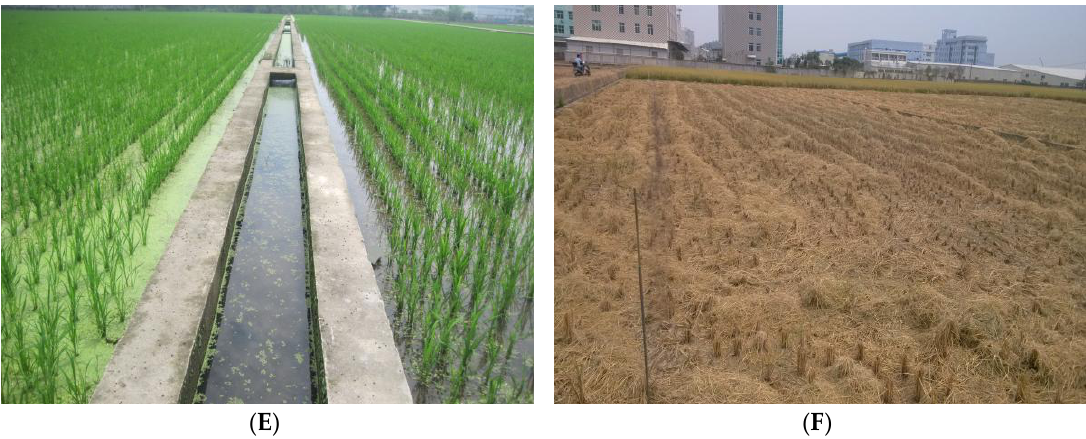
Figure A1. Photographs of the paddy field at various periods of the crop-rotation system ( A ) preparation of vegetable beds; ( B ) vegetable growth; ( C ) fallow after vegetable harvest; ( D ) preparation of rice beds and transplantation; ( E ) rice growth; and ( F ) fallow after rice harvest.